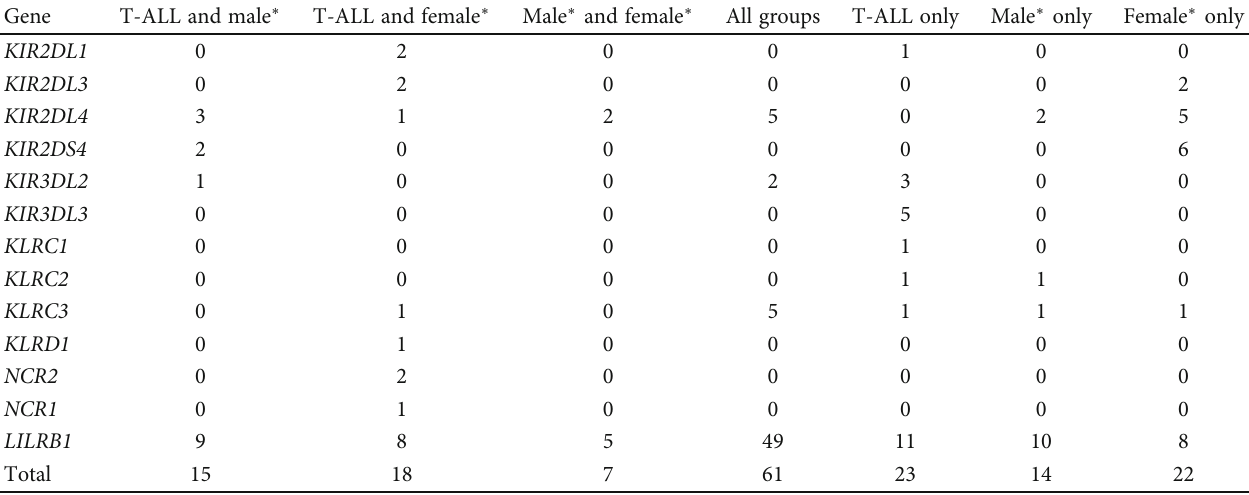
Table 1: Small variants with protein e ff ects in NK cell genes shared between study